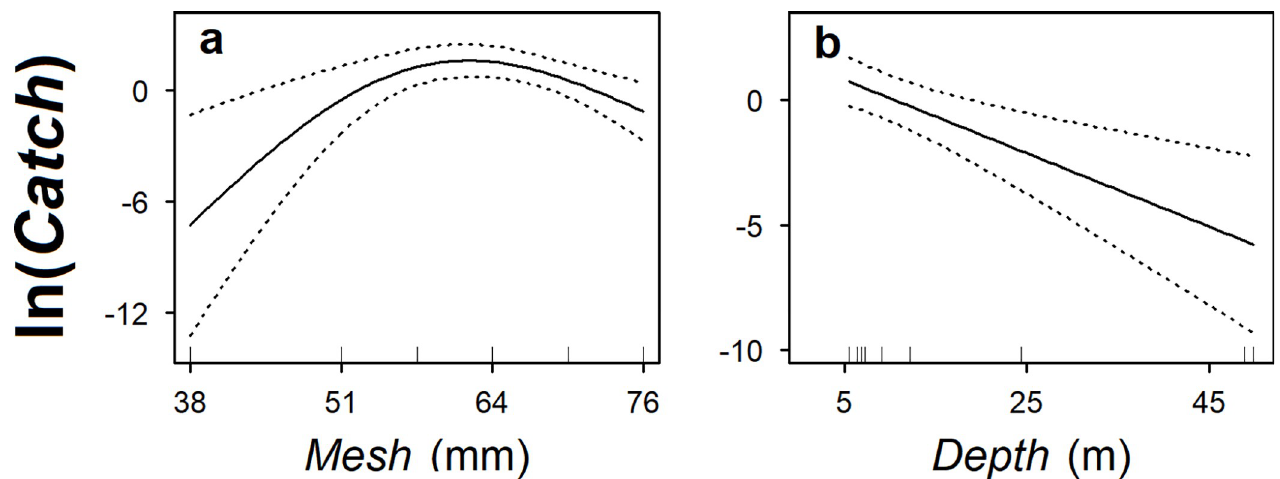
Fig 5. The relationships between predicted number of Cisco caught ( Catch ) and predictors in the selected generalized additive model fitted to gill-net data collected from Saginaw Bay in fall, 1956. Mesh is a continuous variable representing gill-net mesh size (stretch) and Depth is a continuous variable representing bottom depth. Solid lines represent the predicted values, dotted lines represent +/ − one standard error, and ticks above the horizontal axis represent the distribution of data points. The final predicted values of Catch still need to be adjusted for spatial variability (i.e., latitude and longitude), offset values (i.e., gill-net mesh area), and the intercept in the model. At the same scale of ln( Catch ), the model has an intercept of − 4.219, with a standard error of 0.464.